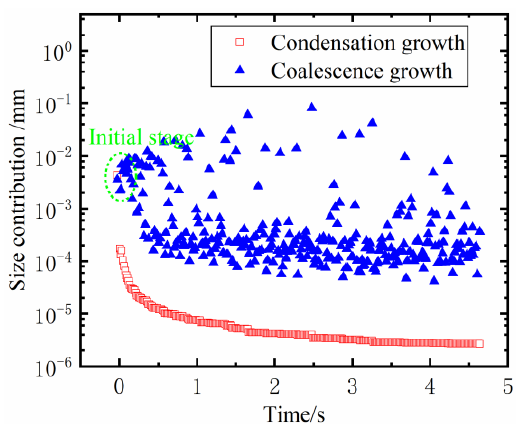
Figure 14. Comparison of the contribution of two growth modes to the maximum droplet size.